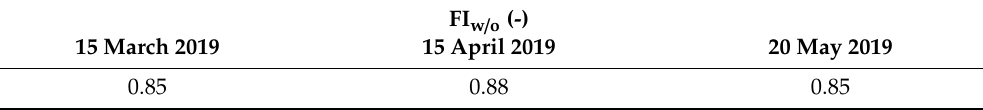
Table 2. Fluorometric index ( FI o / w ) calculated by Formula (2) for the uncontaminated seawater.